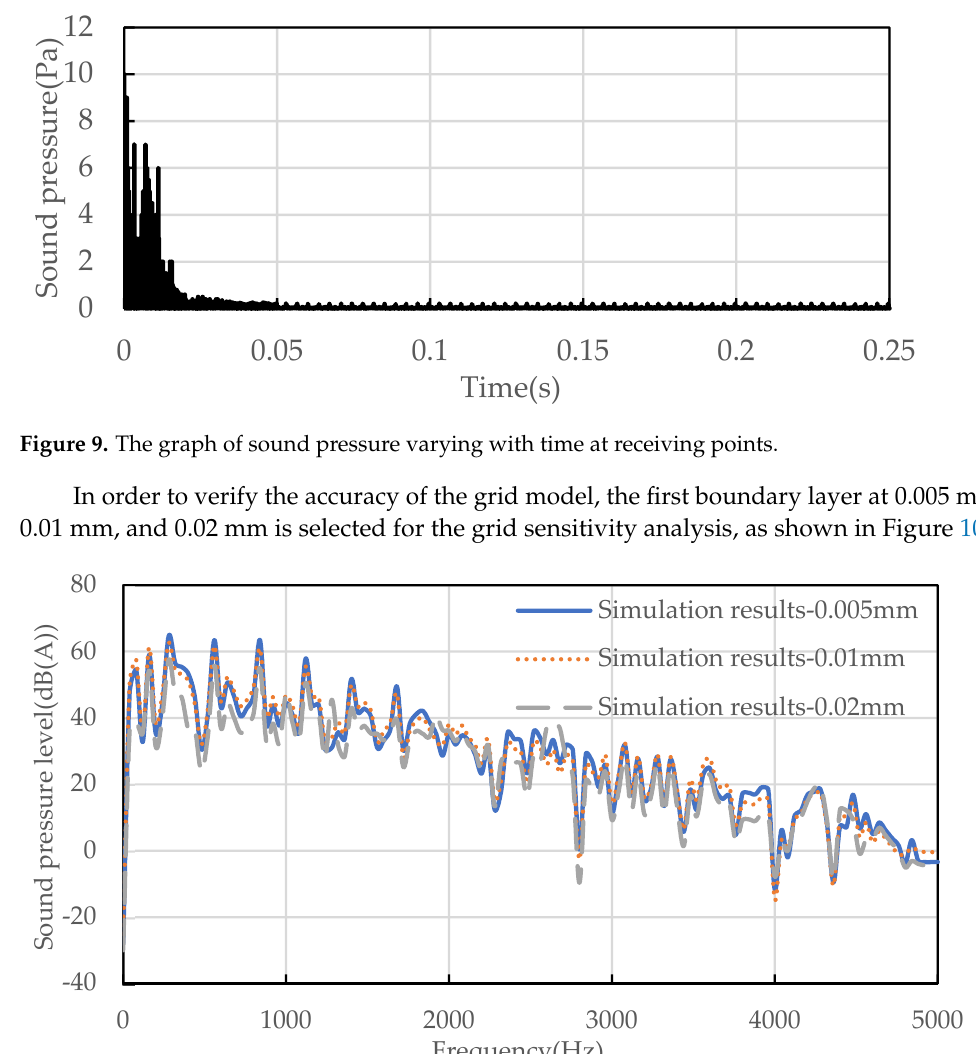
Figure 9. The graph of sound pressure varying with time at receiving points.